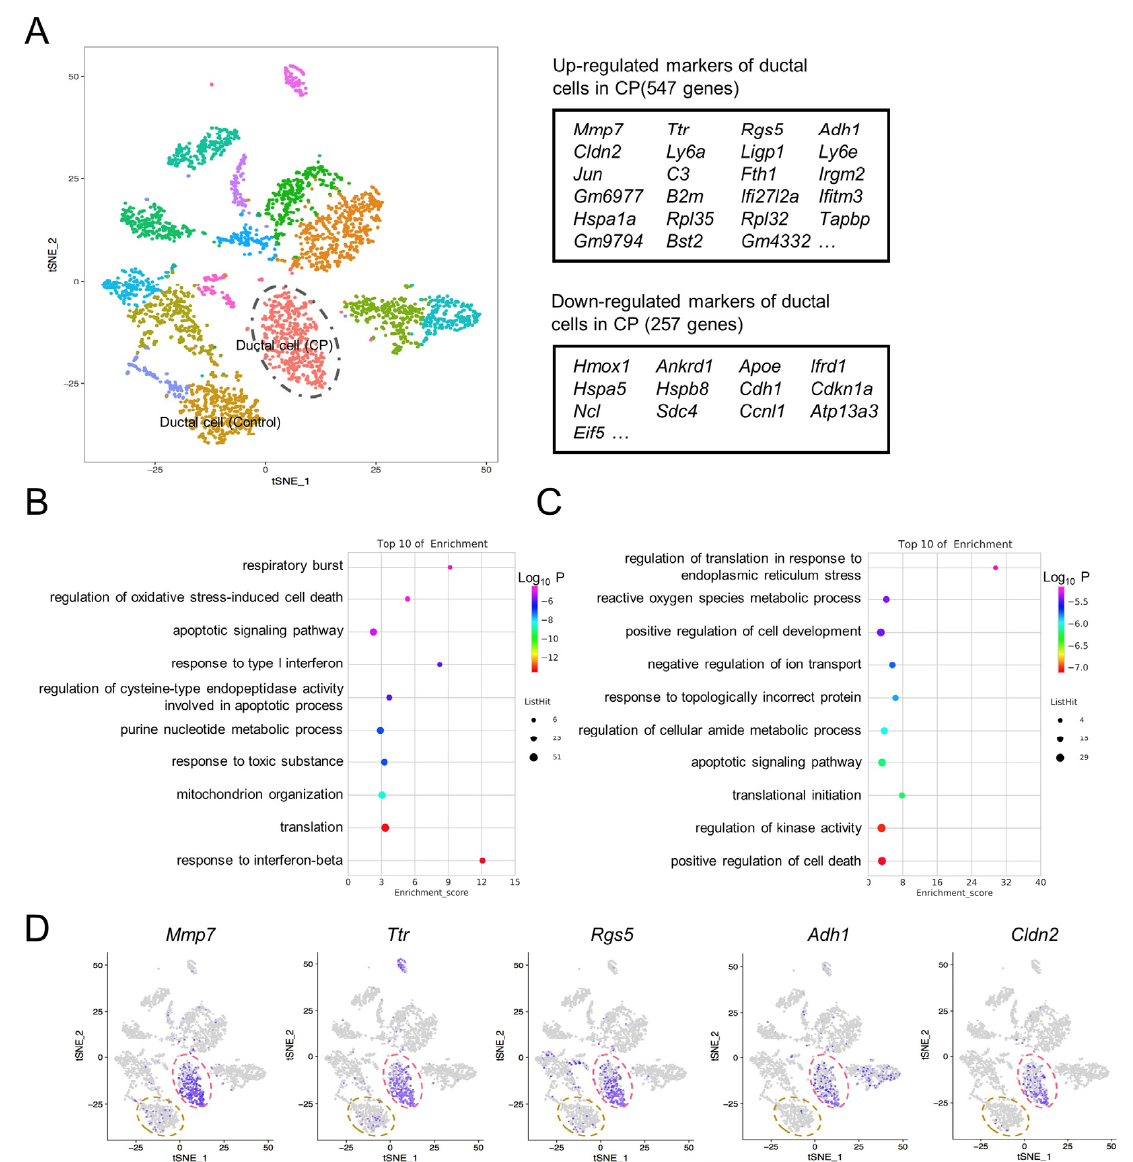
Figure 5. Gene expression alterations in ductal cells in CP mice. ( A ) The t-SNE map demonstrated that ductal cells from the CP group were completely separated from ductal cells from the control group (left panel). Tables denoting the top differentially expressed genes when comparing ductal cells in CP to ductal cells in the control (right panel). ( B ) GO terms enriched for upregulated genes of the ductal cells in CP. ( C ) GO terms enriched for downregulated genes of the ductal cells in CP. ( D ) t-SNE maps indicating marker genes of the ductal cells in CP. The dashed yellow circle represents ductal cells in the control group; the dashed red circle represents ductal cells in the CP group.